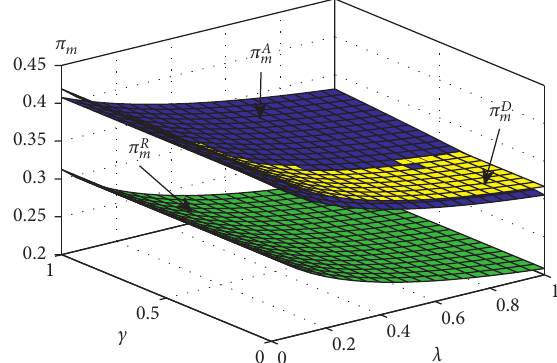
Figure 2: Impact of the retailer’s fairness concerns on the man- ufacturer’s profit.